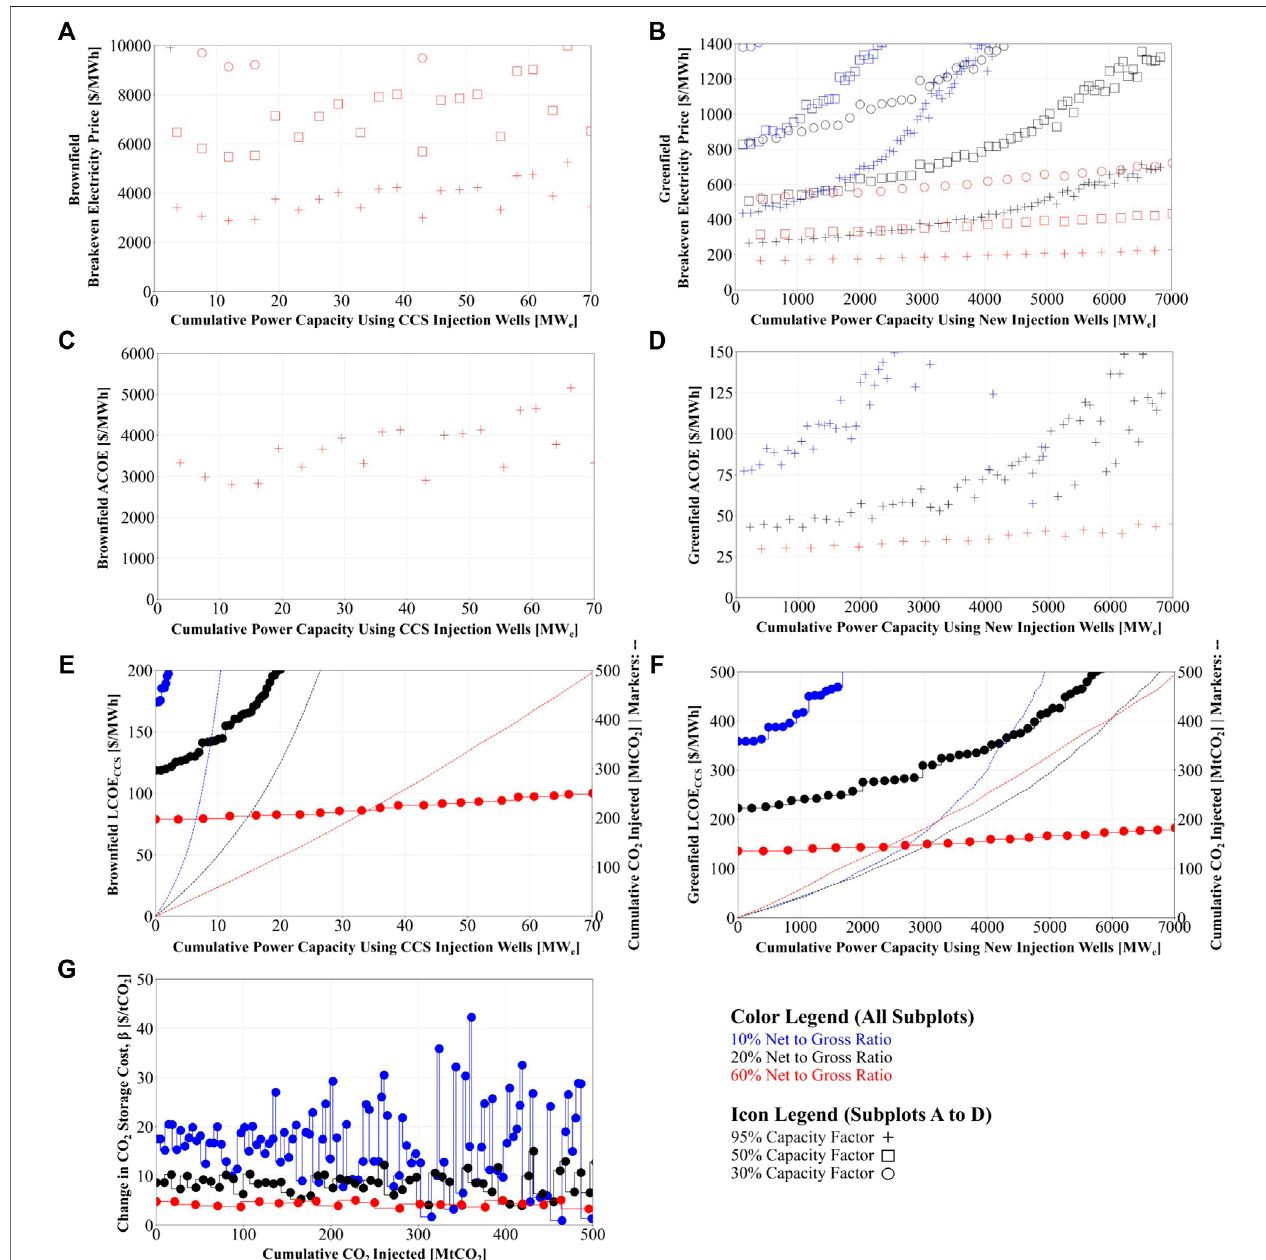
FIGURE 4 | Brown fi eld Breakeven Electricity Prices (A) , Green fi eld Breakeven Electricity Prices (B) , Brown fi eld ACOE Supply Curve (C) , Green fi eld ACOE Supply Curves (D) , Brown fi eld LCOE Supply Curve (E) , Green fi eld LCOE Supply Curve (F) , Change in Cost of CO 2 Storage Between CPG “ sweet spot ” locations and CO 2 storage “ sweet spot ” locations (G) . Subplots E and F also show the cumulative CO 2 injected as a function of the cumulative CPG power capacity on the right y